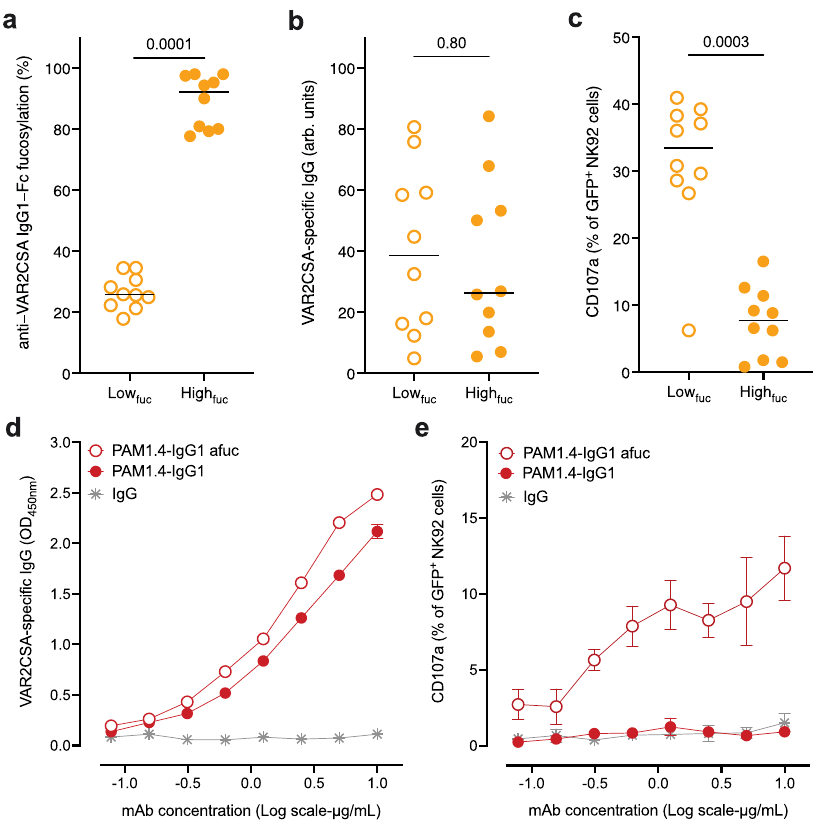
Fig. 5 Afucosylated PfEMP1-speci fi c IgG induces NK-cell-mediated ADCC. a VAR2CSA-speci fi c IgG fucosylation levels of samples with low (open symbols) and high fucose ( fi lled symbols) levels. b Comparison of VAR2CSA-speci fi c IgG levels and c CD107a expression between highly fucosylated ( fi lled symbols) and afucosylated anti-VAR2CSA IgG1 (open symbols) samples, respectively. Mean from three independent experiments and P values from two-sided Mann – Whitney tests are shown. d VAR2CSA-speci fi c, human monoclonal antibody PAM1.4 as either fucosylated or afucosylated IgG1 was titrated in the same assay and VAR2CSA-binding or e degranulation activity (CD107a expression) on NK92-CD16a cells was measured. IgG: non-immune human IgG. Data represent mean values ± SD from three independent